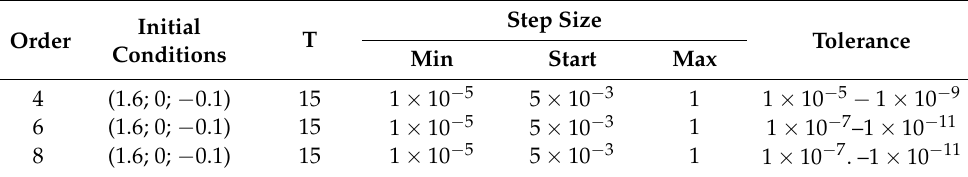
Table 2. Parameter values used in simulation of the Rössler system.